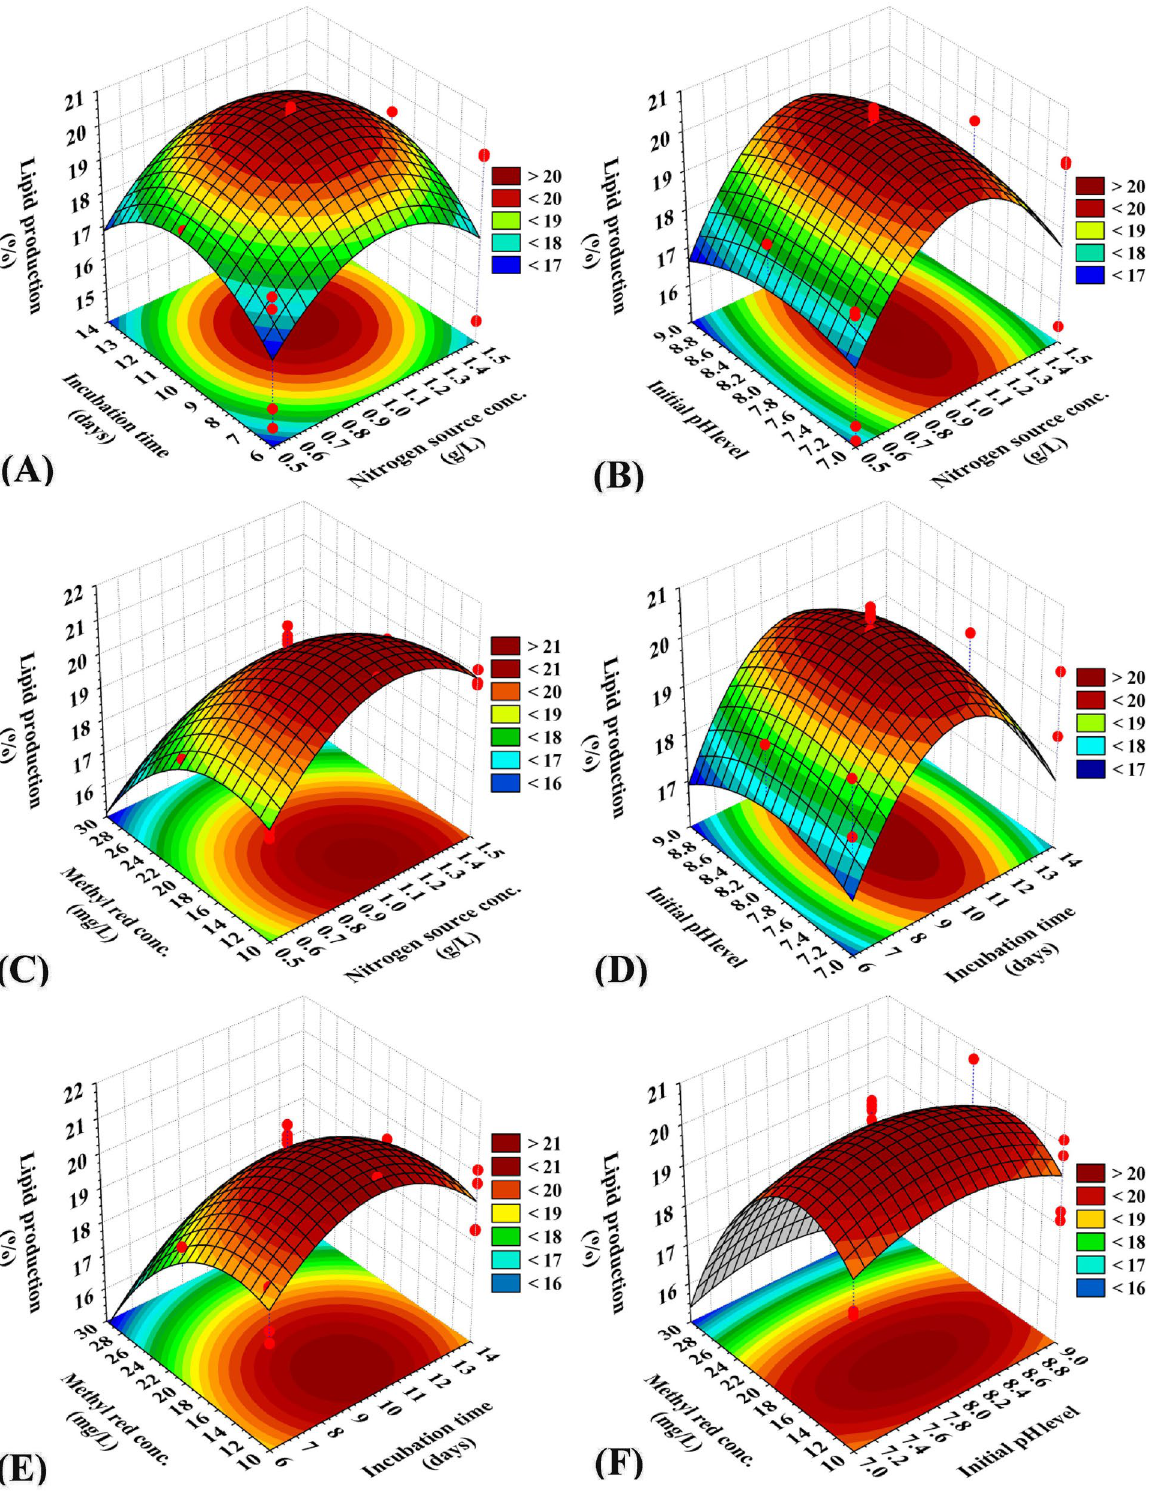
Figure 5. Three-dimensional surface plot for lipid production (%) by using Scenedesmus obliquus , showing the interactive effects of the tested